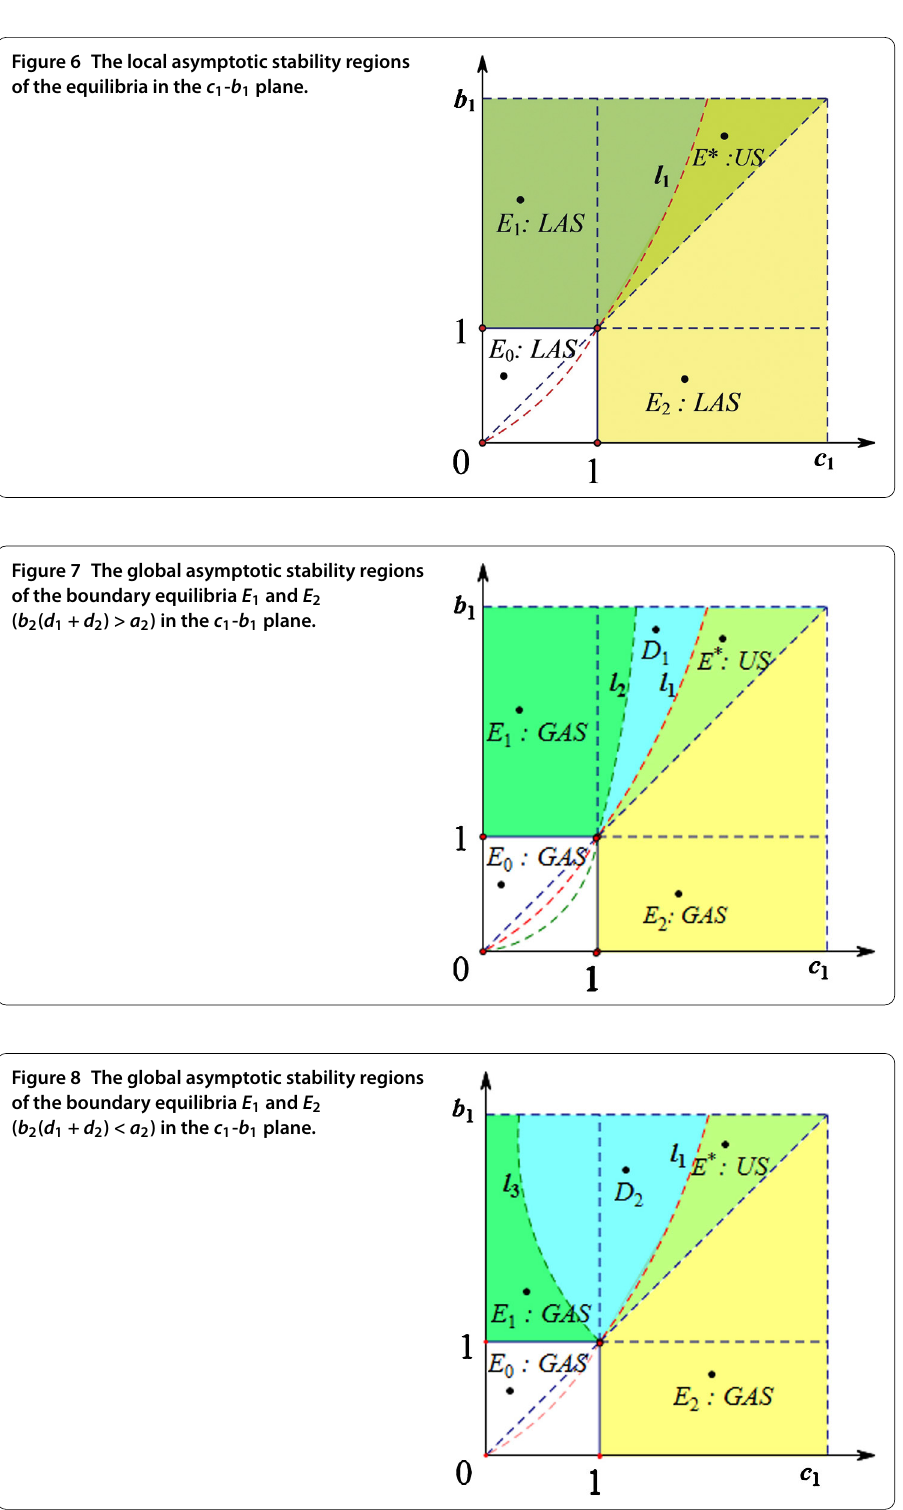
Figure 6 The local asymptotic stability regions of the equilibria in the c 1 - b 1 plane.